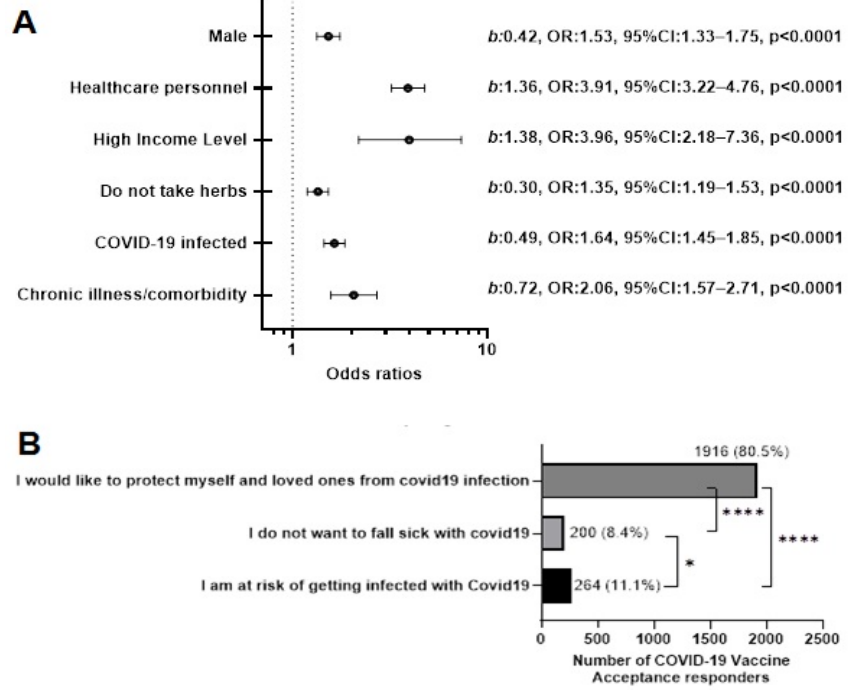
Figure 2. COVID-19 Vaccine Acceptance Cohort. ( A ) Using multiple logistic regression to identify factors that can likely lead to vaccine acceptance. ( B ) The reasons why persons in the vaccine acceptance cohort would give their consent to take a COVID-19 vaccine. * p < 0.01, **** p < 0.00001. The different bar colours represent the different options for the participants.